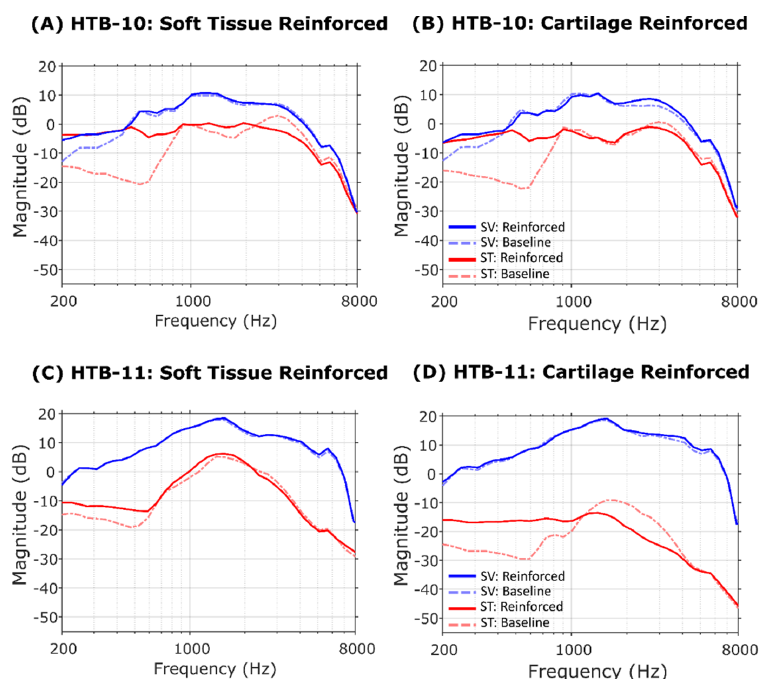
Figure 5. Two exemplary cases for the ICSP gain changes in ST and SV after the reinforcement of the RWM with soft tissue and cartilage compared to the respective baselines for HTB-10 ( A , B ) and HTB-11 ( C , D ). The bold lines represent the ICSP gain after reinforcement in each scenario for ST and SV (red and blue, respectively) and the dotted line pattern for the baselines in the same light color shades.